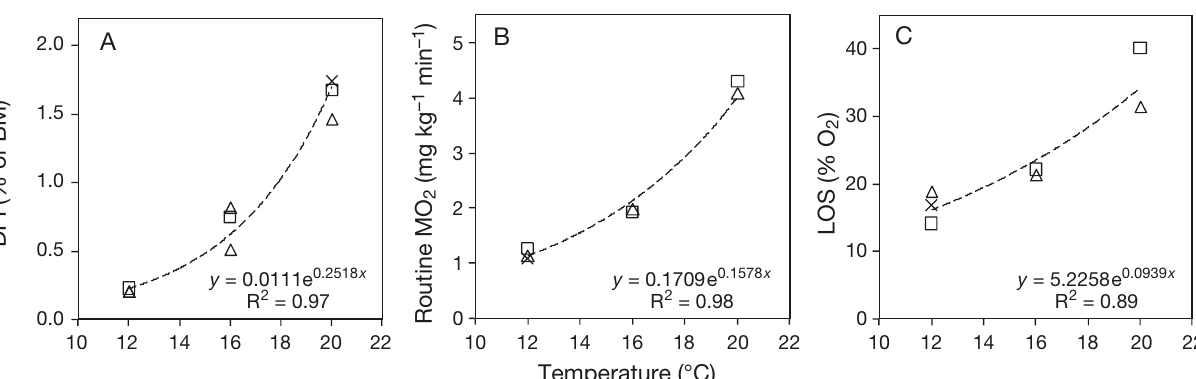
Fig. 2. Relationship between temperature and (A) the daily feed intake (DFI, % of biomass, BM, measured on the day before limiting oxygen saturation, LOS, measurement), (B) the routine oxygen consumption rate (routine MO 2 , mg O 2 kg −1 min −1 ) and (C) the LOS (% of air saturation) in 3 replicate tanks with groups of undisturbed, fed and freely swimming adult gilthead sea bream Sparus aurata . Each replicate tank is given a separate symbol in the graphs (note that one replicate is missing for MO 2 and LOS measurements at 16 and 20°C). Measurements at 20, 16 and 12°C were performed on Days 12, 20 and 28, respec- tively, after 8 d of temperature acclimation. In all panels, exponential trend lines are fitted to the data, and the resulting